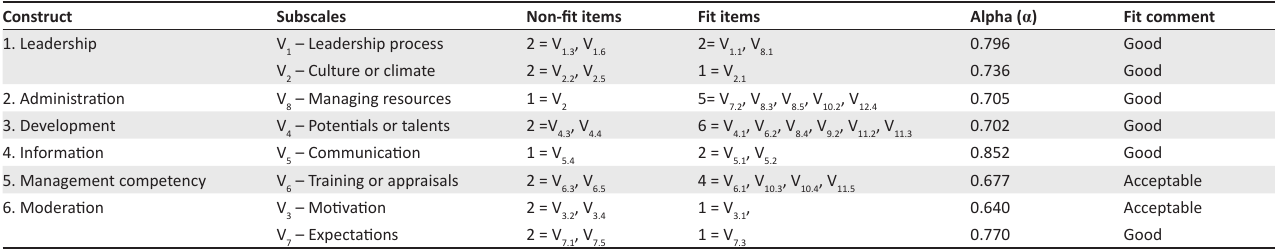
TABLE 9: Alpha coefficients and items for constructs of the study.